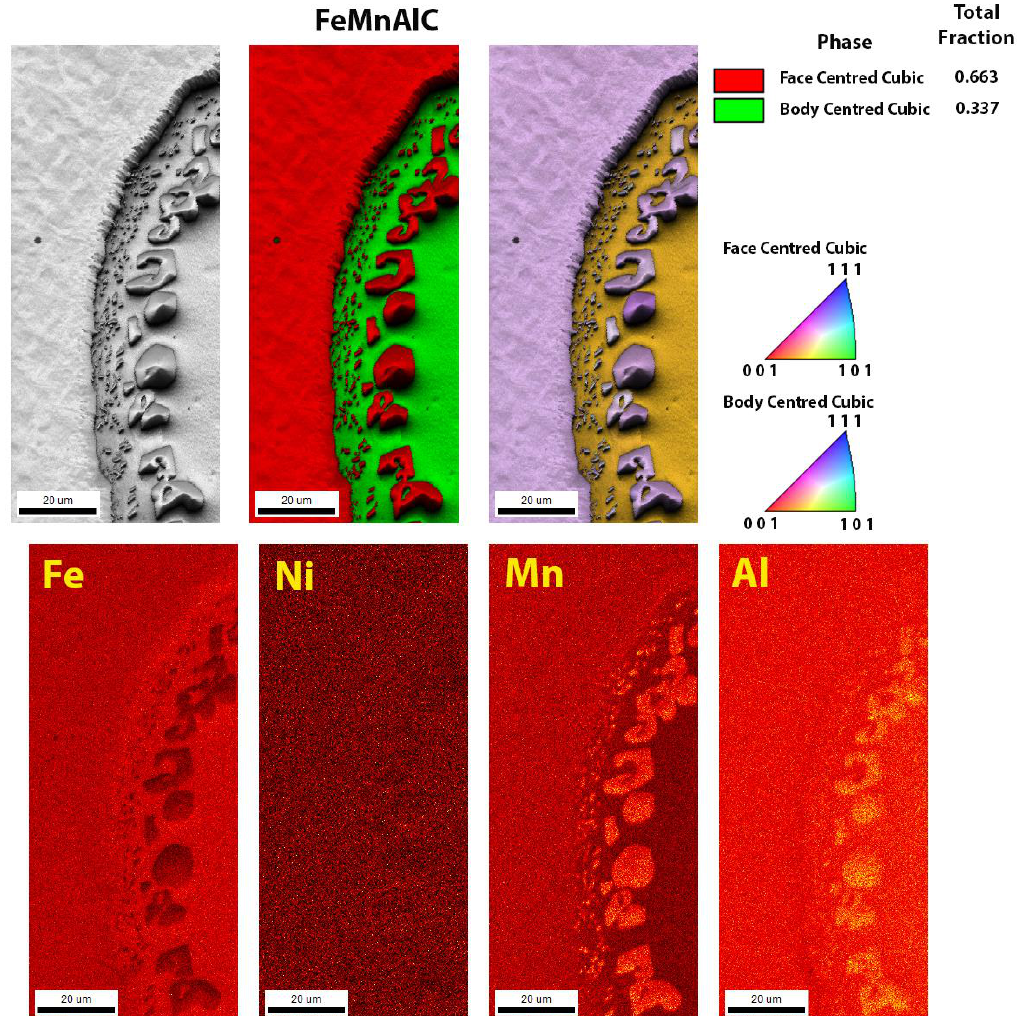
Figure 5. Electron backscattered diffraction analysis of a sample as-cast FeMnAlC sample and SEM EDS (Energy-dispersive X-ray spectroscopy) elemental mapping of Fe, Ni, Mn, and Al.